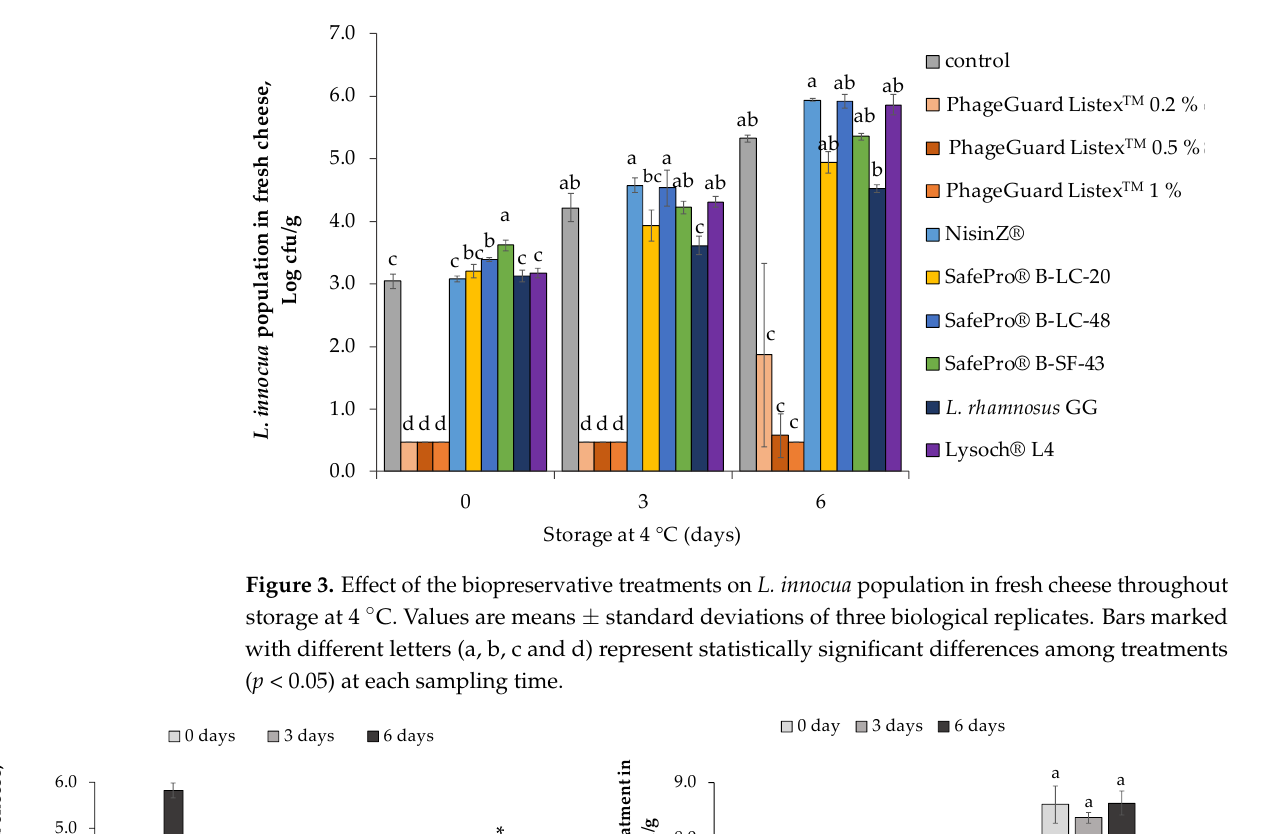
Figure 3. Effect of the biopreservative treatments on L. innocua population in fresh cheese through- out storage at 4 °C. Values are means ± standard deviations of three biological replicates. Bars marked with different letters (a, b, c and d) represent statistically significant differences among treatments ( p < 0.05) at each sampling time.